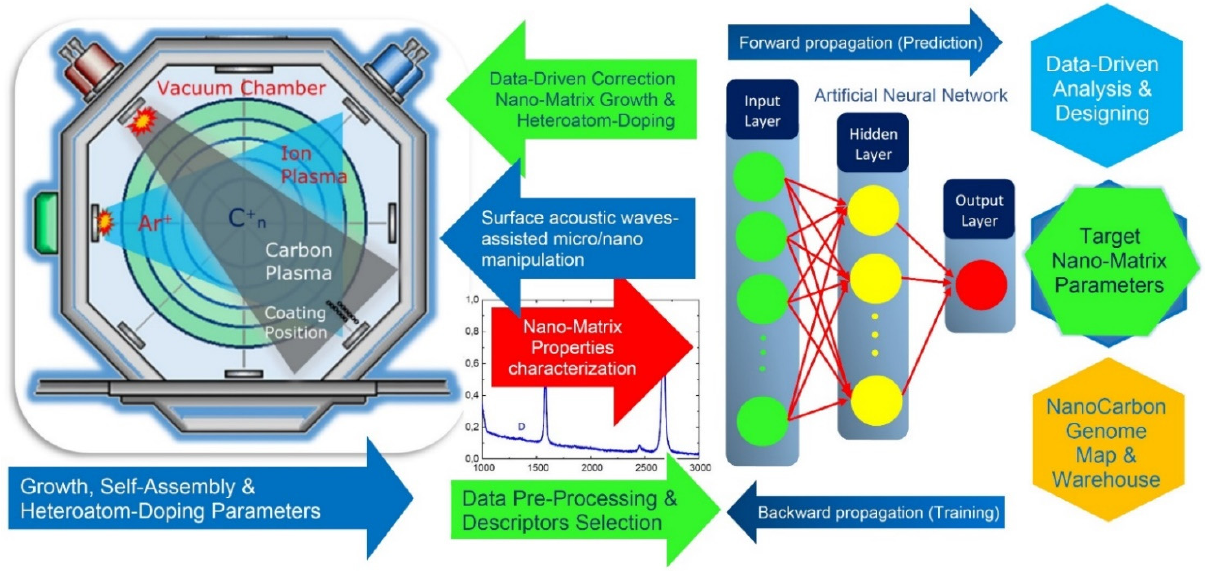
Figure 12. Machine learning-based fine-tuning of the functionalizing nanocarriers: a scheme of tracking and tailoring the key descriptors and linkages for incorporating into the data-driven carbon nanomaterials genome approach.